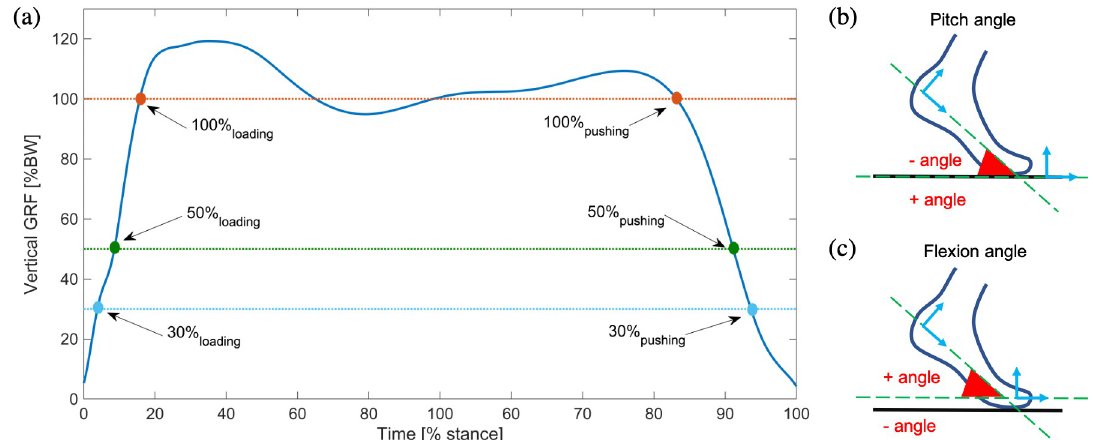
Fig 3. Segmentation of the stance phase and angle definitions. (a) Segmentation of the stance phase based on the normalized vertical ground reaction force. (b) Diagram of the pitch angle ( α pitch ) defined as the angle between the longitudinal axis of the rearfoot segment and the ground surface. (c) Diagram of the flexion angle ( α ) defined as the angle between the vertical axis of the rear foot segment flexion and the forefoot